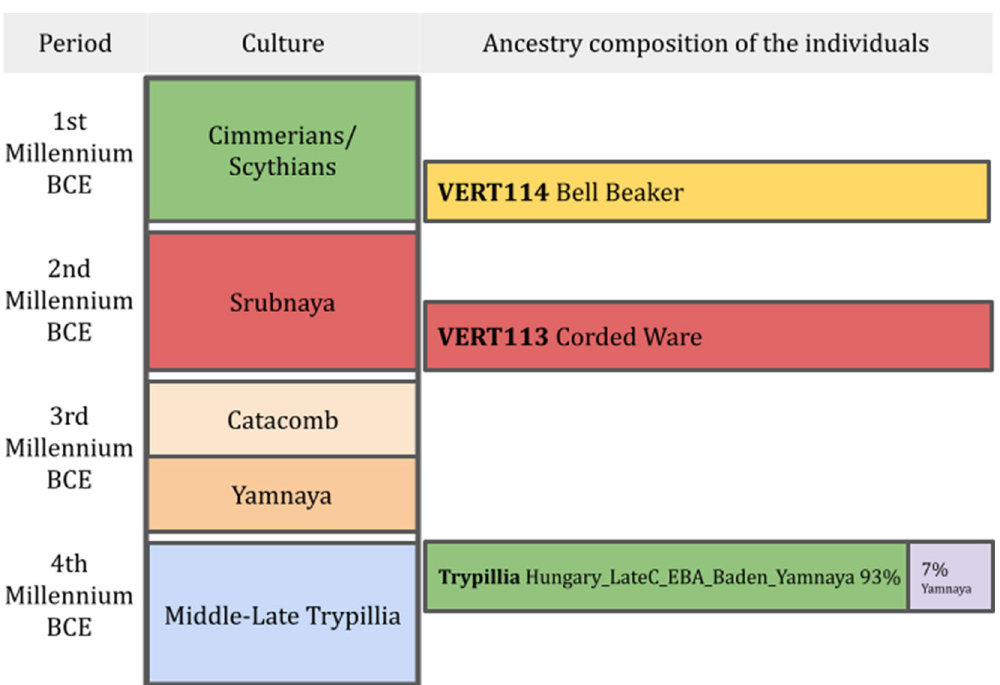
Figure 4. Ancestry and culture summary: Chronology of the different cultures that settled in Ukraine between the 4th and the 1st Millenium BCE, on the right the ancestry components of the analyzed individuals from Verteba cave according to the qpAdm analyses. The colors on the period column represent the different historical periods in the west of Ukraine. The Ancestry composition column colors graphically show the results of qpAdm. Green corresponds to Hungary_LateC_EBA_Baden_Yamnaya, Violet to Yamnaya, Red to Corded_ Ware and Yellow to